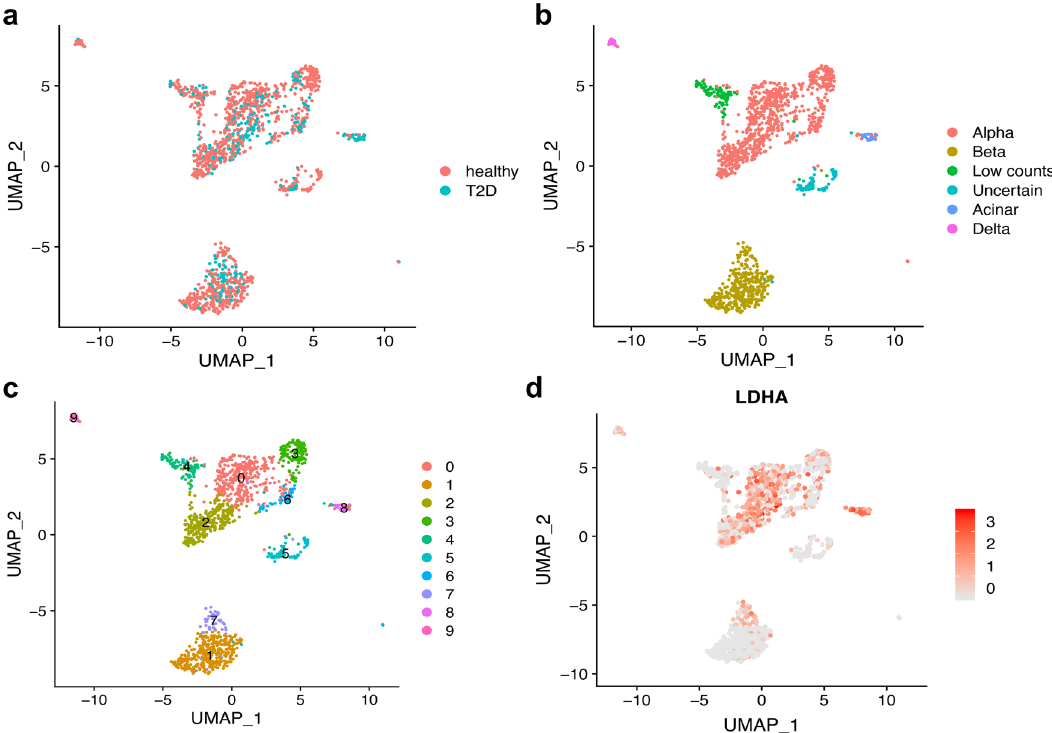
Fig. 5 Cluster-7 β -cell subpopulation overlaps with LDHA-positive β -cells with HIF1 α signature. a UMAP plot of cluster distribution of 1,482 pancreatic cells coloured by disease conditions (health and T2D). b UMAP plot of cluster distribution and coloured by cell-type annotations [ α -cells (alpha), β -cells (beta), cells with low counts, cells with non-veri fi ed identity, acinar cells and ductal cell]. c UMAP plot coloured by unsupervised clusters. d UMAP plot showing LDHA expression. The colour scale represents normalised expression level of the gene. Published sc RNA-Seq in 23 was presented in a quantitative way to compare nine identi fi ed pancreatic-cell subpopulations in the top differentially expressed